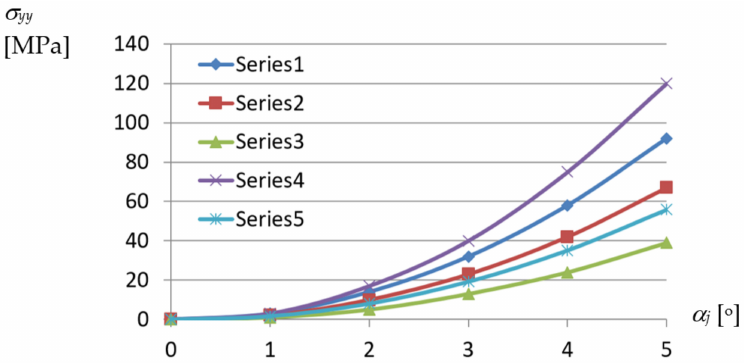
Figure 24. Comparison between the dependencies obtained for σ yy normal stresses acting orthogo- nally to fold’s longitudinal axes in relation to α j unit twist angle of the transformed sheets of profiles: Series1—TR50 × 0.75 mm × 6.2 m (called Serie1); Series2—TR60 × 0.75 mm × 6.2 m; Series3— TR130 × 0.75 mm × 6.2 m; Series4—TR85 × 0.75 mm × 5.0 m; Series5—TR85 × 0.75 mm × 5.0 m (the computational thin-walled